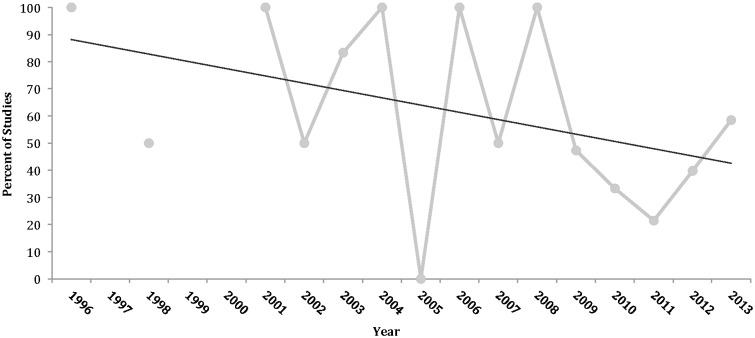
Present or not reported financial conflict of interest over time for all continents combined. COI, conflict of interest.